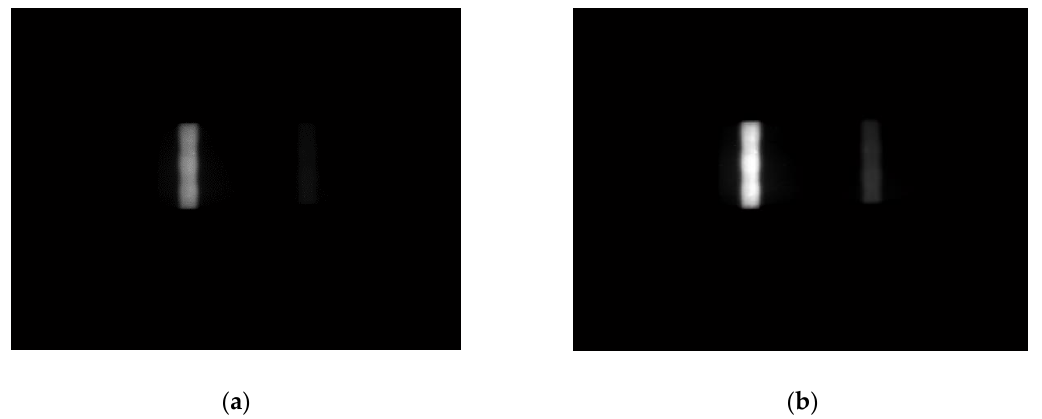
Figure 7. Detection result of a low-concentration strip: ( a ) original image; ( b ) after range adjustment.